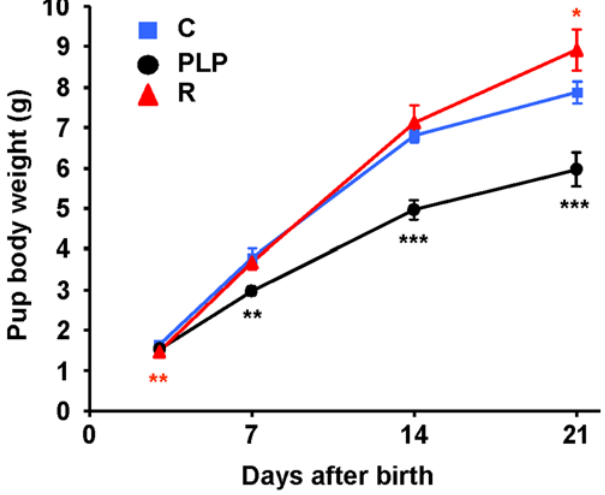
Figure 1. Growth curves of pups of control, postnatal low protein and recuperated mice during lactation. Body weights of pups were recorded at days 3, 7, 14 and 21 of age. To maximize the effects of maternal diet, recuperated pups (R) were culled to 4 and control pups (C) were culled to 8 (if litter size was greater than 8) whereas postnatal low protein pups (PLP) were unculled. Means 6 SEM are shown (* P , 0.05, ** P , 0.01, *** P , 0.001 compared to control; n=C: 13, PLP: 11, R: 16).